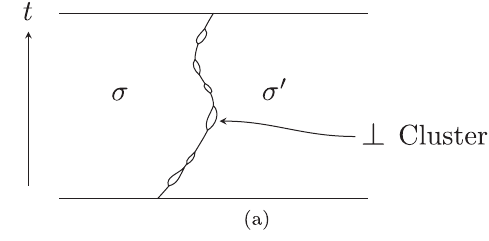
FIG. 2. Thick membrane (schematic). Except in the special case of Haar-averaged unitaries, the membrane (a domain wall between permutations σ and σ 0 ) is thickened by clusters where the effective spin takes the value “ ⊥ . ” In the multilayer tensor network for U ð N Þ , this value represents the propagation of states orthogonal to paired states. (In general, the interior of the thick membrane also contains paired states. For N > 2 , these may be distinct from σ or σ 0